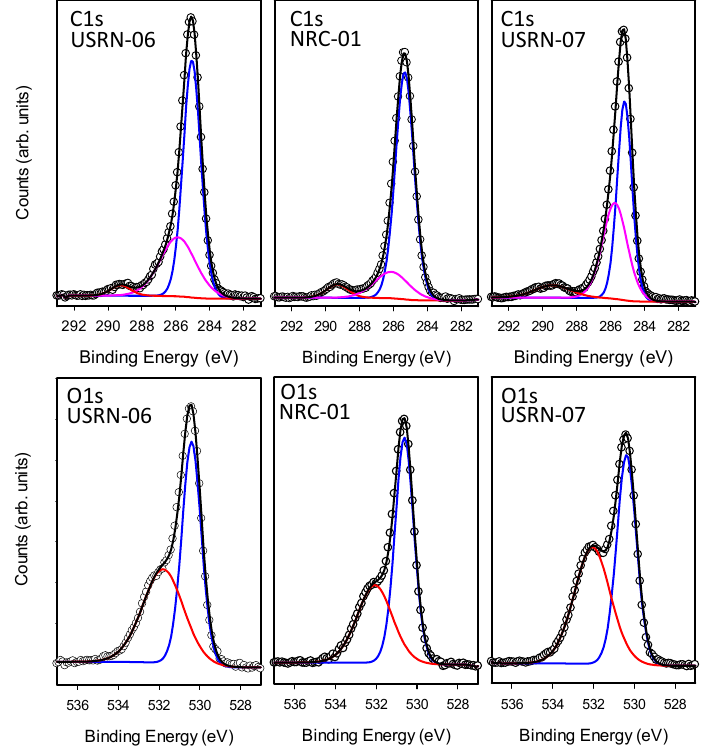
Figure 7. XPS spectra of the C1s (top) and O1s regions for 3 stearic acid-modified ZnO samples. The spectra are fit with a Shirley background and mixed Gaussian-Lorentzian peaks (GL30) using CASA-XPS software. The variously colored peaks correspond to the components in Table 3; C1s blue (C1), pink (C2), red (C3) and dark red (C4), O1s blue (O2) and red (O3).